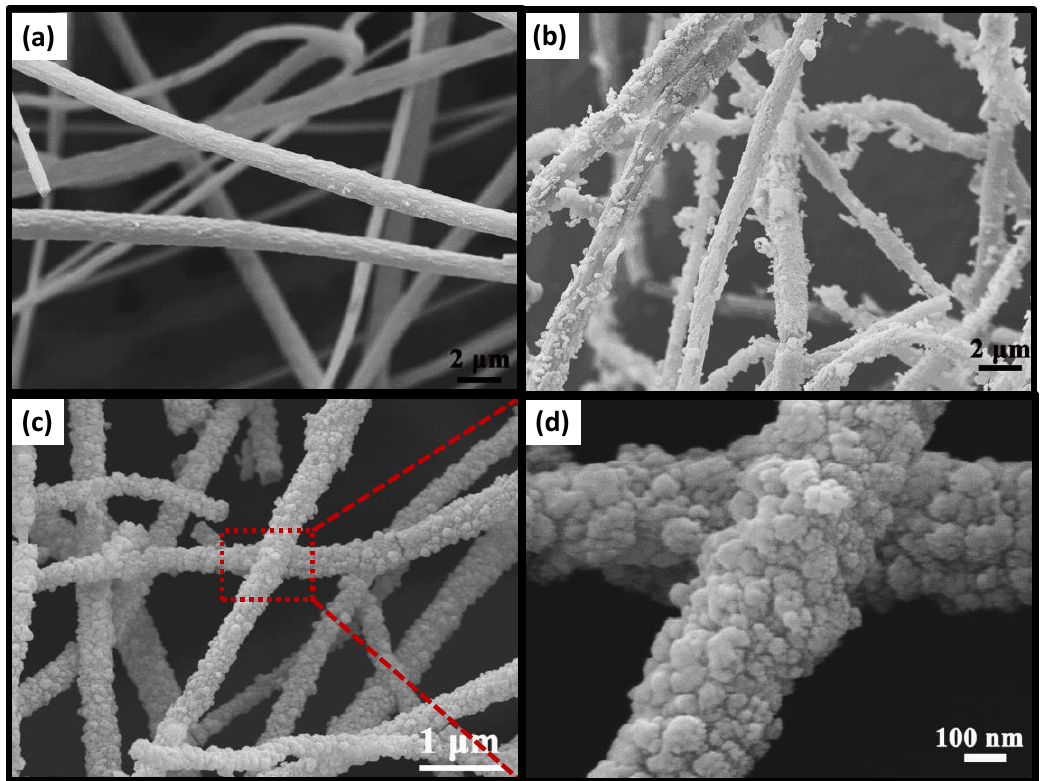
Figure 3. SEM images of ( a ) TBOT/PVDF fibers, ( b ) TiO 2 /PVDF fibers, ( c ) TiO 2 /PVDF@MoS 2 fibers, and ( d ) high resolution SEM image of TiO 2 /PVDF@MoS 2 core-shell heterostructured fibers.